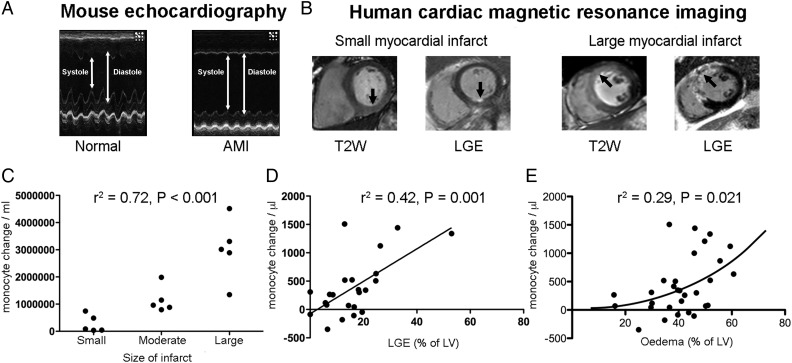
The extent of the monocyte response correlates with the extent of myocardial injury. (A) Transthoracic echocardiography of mouse hearts following acute myocardial infarction (n = 6/group). (B) Cardiac magnetic resonance imaging to quantify area of injury (T2-weighted sequence) and infarction (LGE sequence) in humans (n = 30 acute timepoint, n = 23 follow up). (C) In mice, the total peripheral monocyte count was highly correlated with size of infarct (r2 = 0.72, P < 0.001). (D) In humans, the magnitude of the monocyte response for each patient following acute myocardial infarction correlated with the extent of irreversible myocardial injury determined by LGE at 6 months (r2 = 0.42, P = 0.001) and weakly (non-linear relationship) with the area of risk, as measured by oedema (r2 = 0.29, P = 0.021, E).